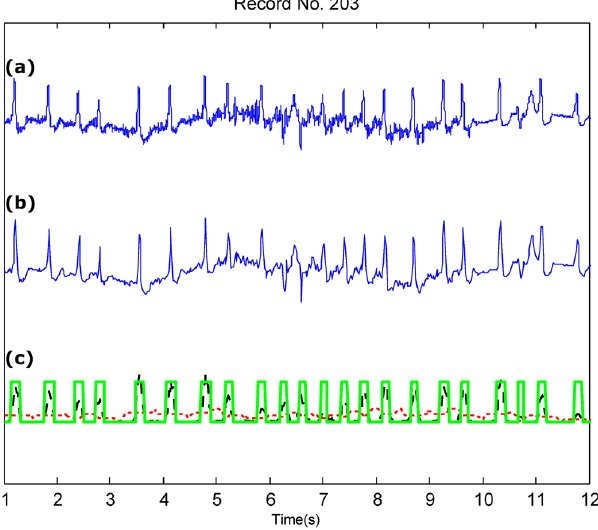
Figure 4. QRS detection over Record 203 of the MIT-BIH Arrhythmia Database with severe baseline drift and noise. ( a ) Original ECG signal ( b ) Compressed ECG signal using Method III ( c ) Compressed ECG signal using Method III with adaptive thresholding and detected QRS complexes (green blocks). Signal amplitudes have been manipulated to fit all signals in one figure. Here, the red dotted line represent the first moving average where the black dashed line represents the second moving average.